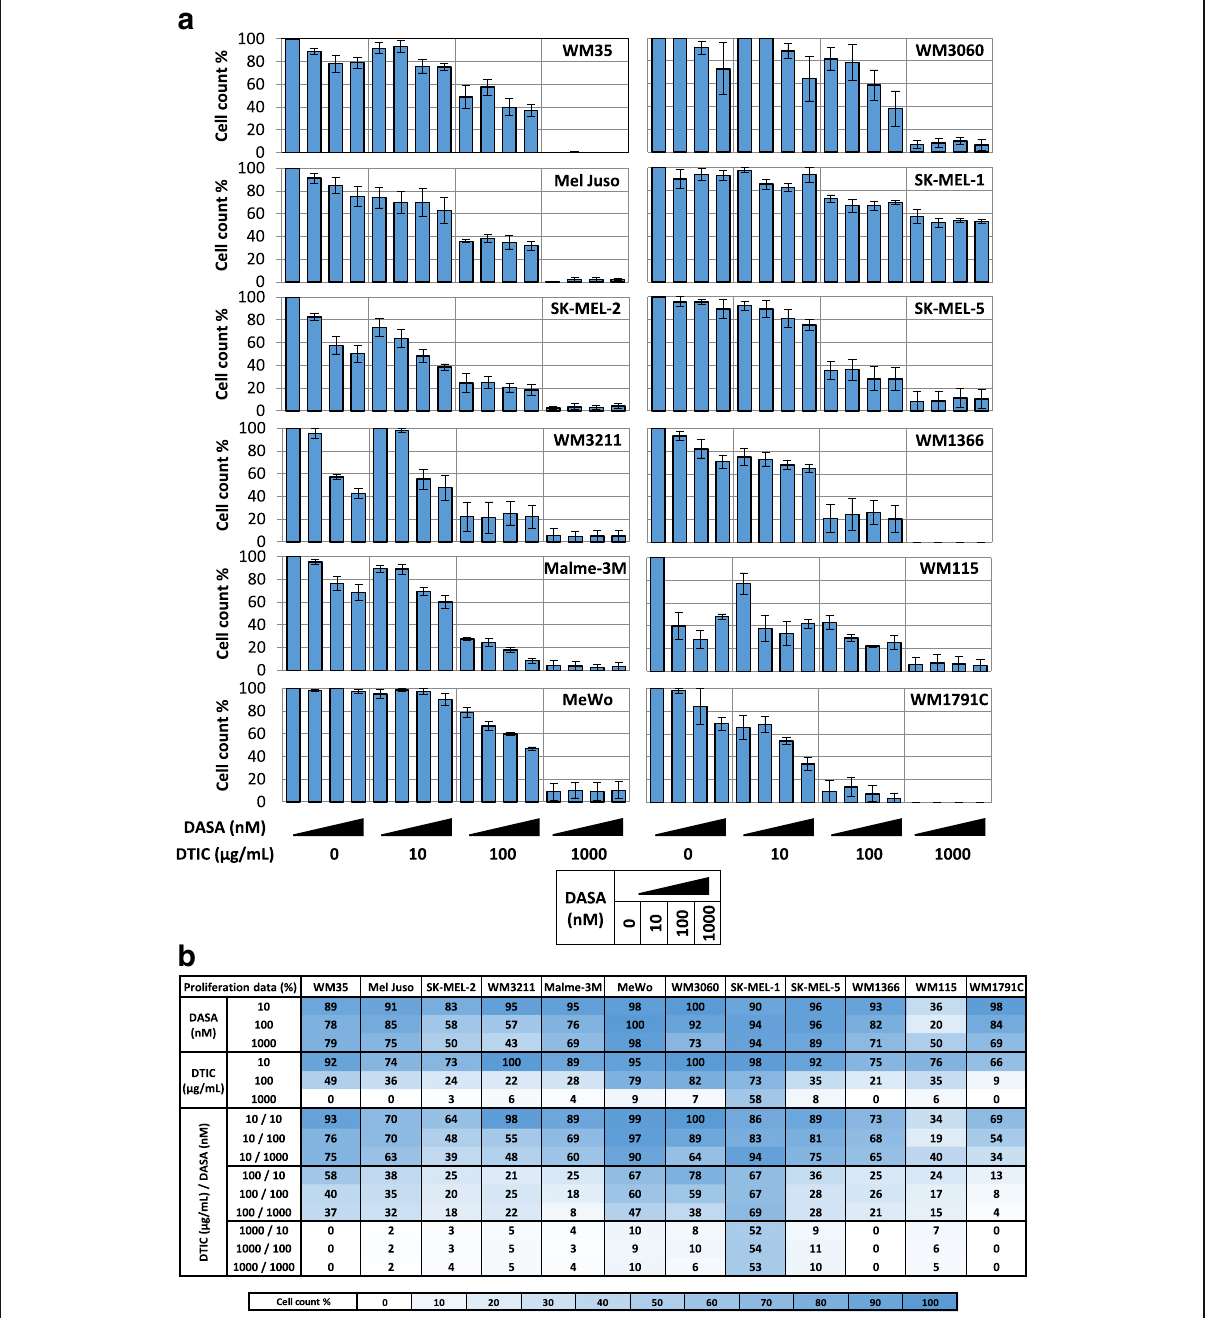
Fig. 1 Heterogeneous growth arrest in melanoma cells treated with dasatinib, alone or in combination with dacarbazine. a Cell proliferation (cell count) of melanoma cell lines after single and combination treatment with dasatinib and dacarbazine (72 h). Bars represent mean values of percentage change normalized to the control. Data are from three independent experiments, each run with triplicate samples. Error bars show SEM. b Summary table of cell proliferation data from ( a